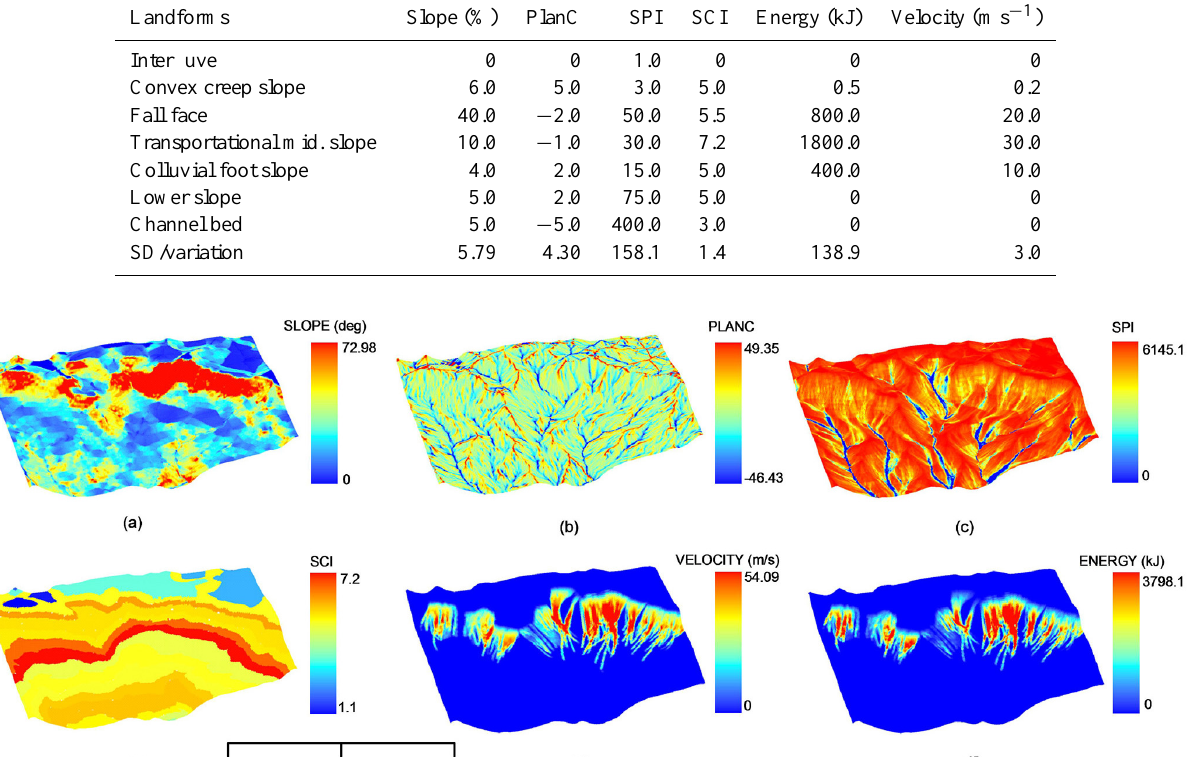
Figure 2. Morphometric variables: (a) slope, (b) plan curvature, (c) stream power index, (d) shape complexity index, (e) rockfall velocity, and (f) rockfall